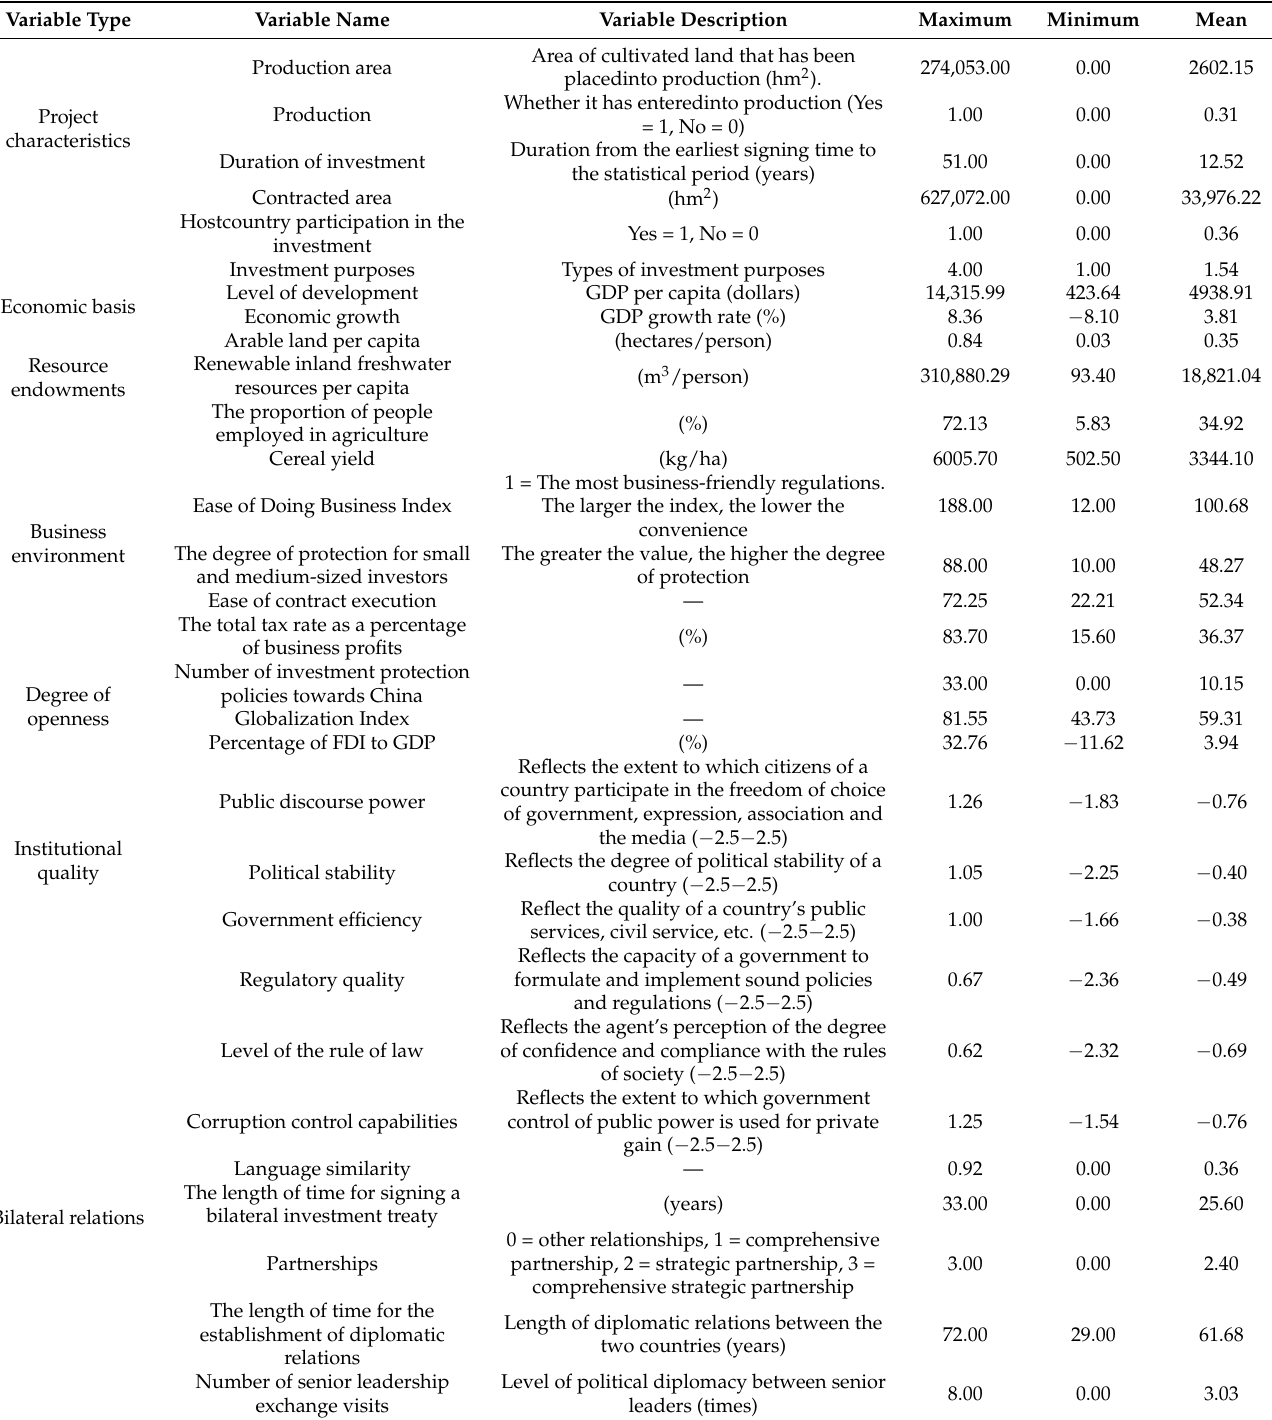
Table 1. Selection and description of